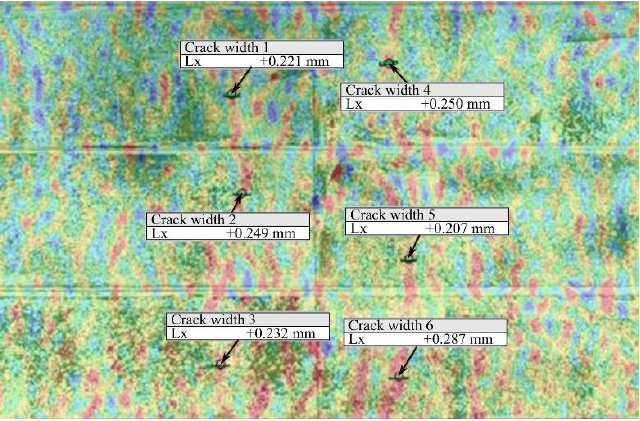
Figure 13. Crack widths at crack detection—lab test. The measured values are given in Table 2, without and with the correction for out-of- plane error [38–40]. Only the out-of-plane component is included in the correction, since no x-direction rotation occurs at mid-span. The values are compared with examples of threshold values, (1) the EC2 threshold for SLS ( w max ≤ 0.2 mm for prestressed concrete elements) and (2) the threshold from the German guideline ( w max ≤ 0.5 mm for new cracks). Table 2. Measured and corrected crack widths at crack detection—lab test. Crack Width